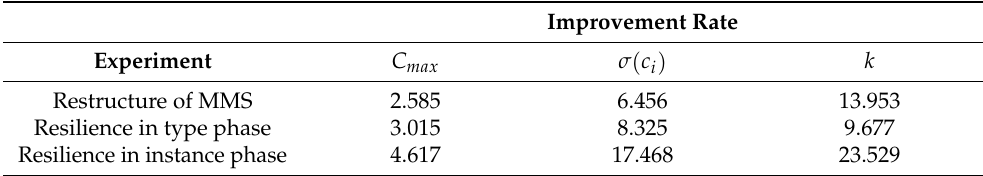
Table 6. Result of application of the proposed method (unit: